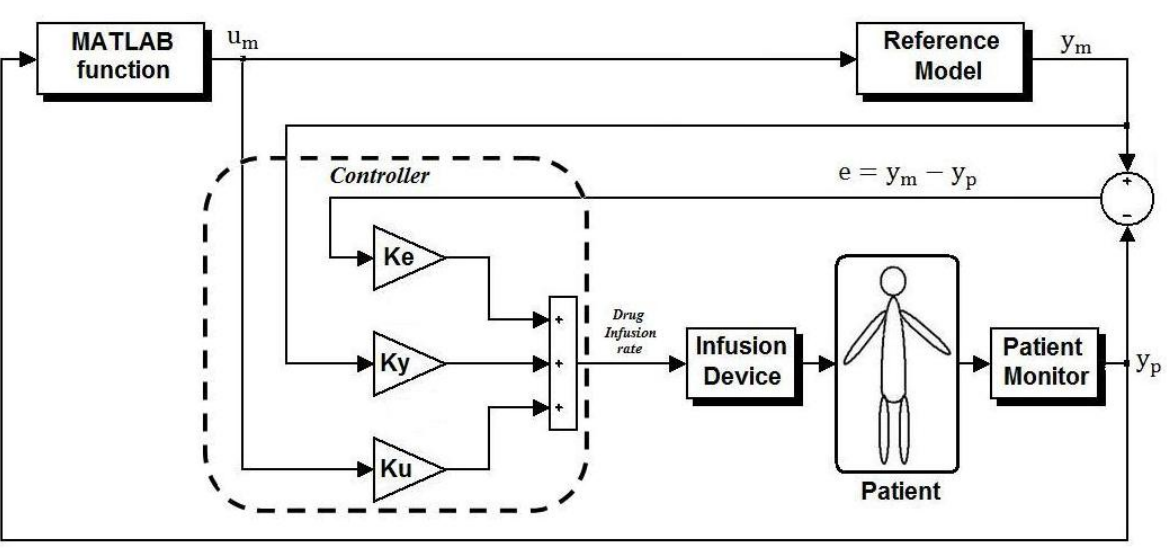
Figure 2: General form of the patient’s model with